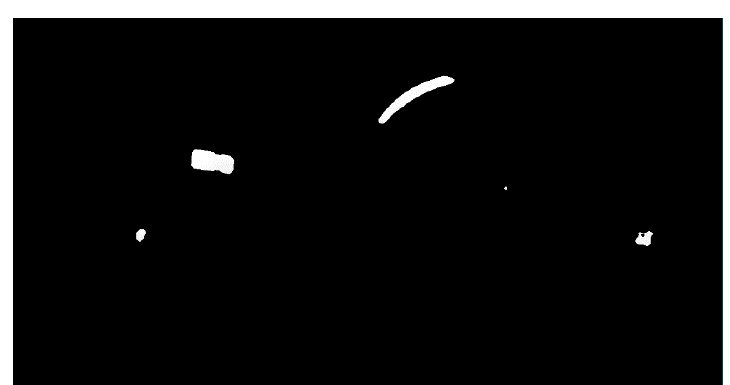
Figure 8. Image thresholding.